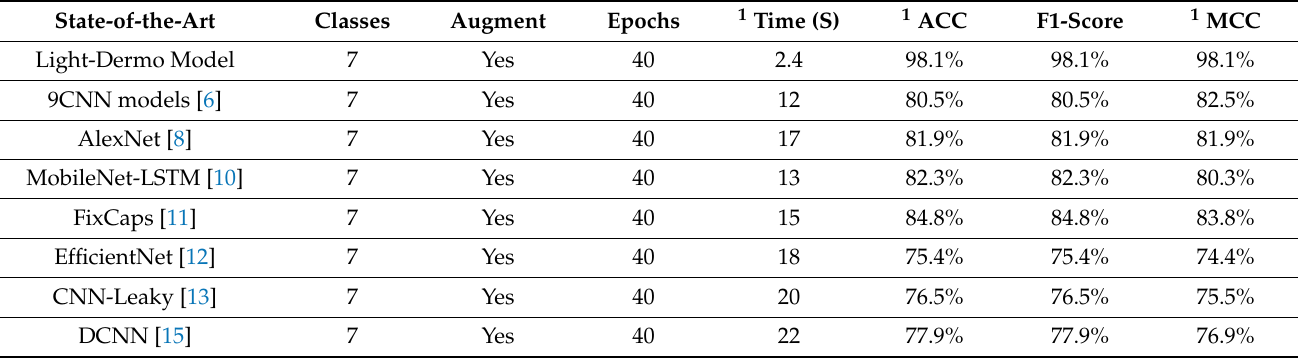
Table 6. Comparisons results of the various TL-based DL